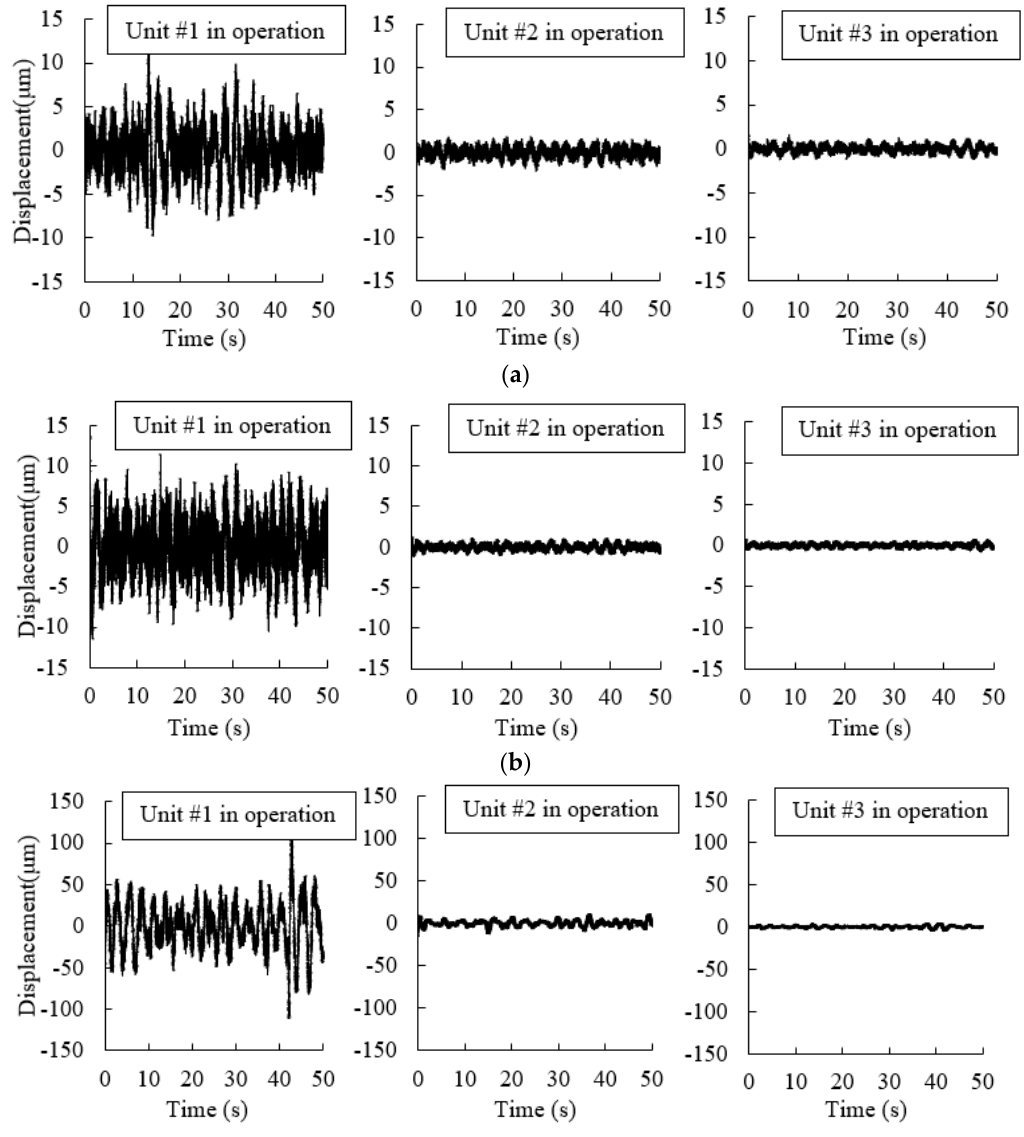
Figure 8. Time histories of vibration displacements in three directions: ( a ) X direction; ( b ) Y direction; and, ( c ) Z direction.